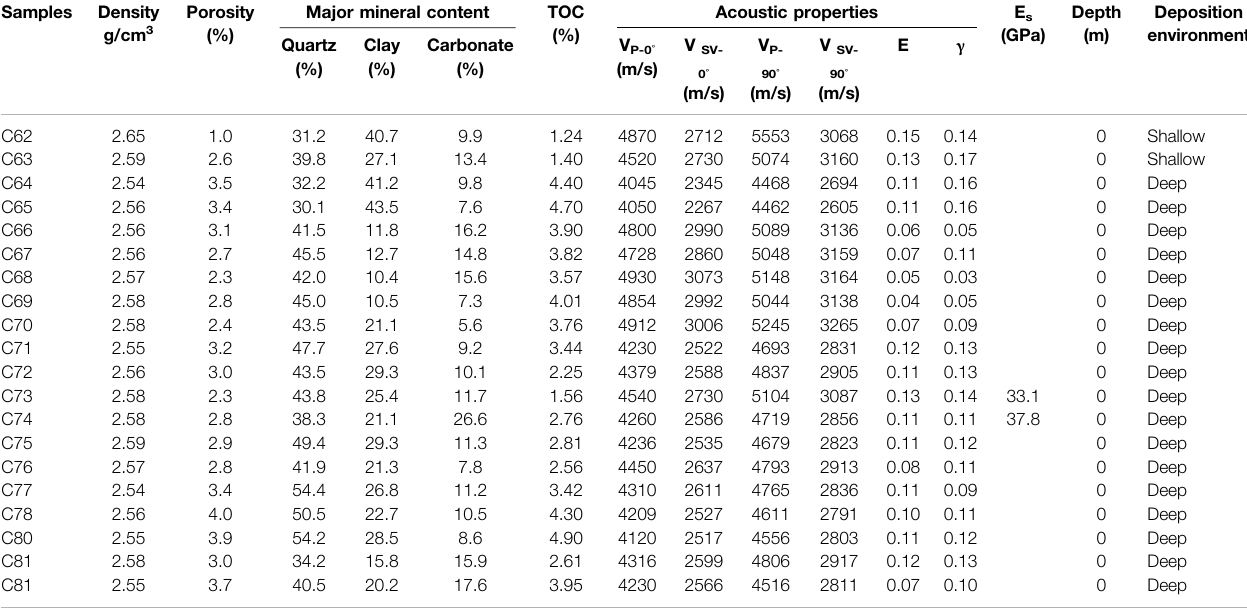
TABLE 1 | ( Continued ) Database of mineral content and rock physical properties of sales sample at 30 MPa con fi ning